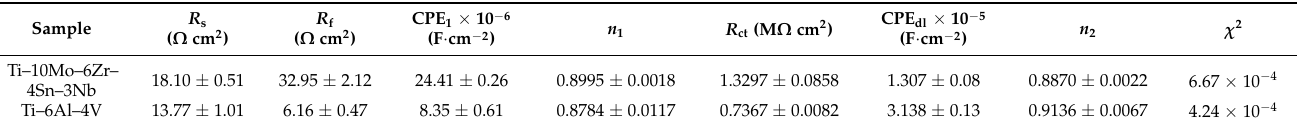
Figure 5. Electrochemical impedance spectroscopy of Ti–10Mo–6Zr–4Sn–3Nb and Ti–6Al–4V in Hank’s solutions at 37 ◦ C: ( a ) Nyquist plots and ( b ) Bode phase angle plots. The inset is the equivalent electrical circuit for fitting the data. Table 3. Fitting results of electrochemical impedance spectra for Ti–10Mo–6Zr–4Sn–3Nb and Ti–6Al–4V after the OCP tests in Hank’s solutions at 37 ◦ C. R f means film resistance, R ct indicates charge transfer resistance, CPE describes charge transfer capacitance, n 1 and n 2 are the exponents of CPE 1 and CPE dl , and χ 2 is the sum of squares of the differences between theoretical and experimental